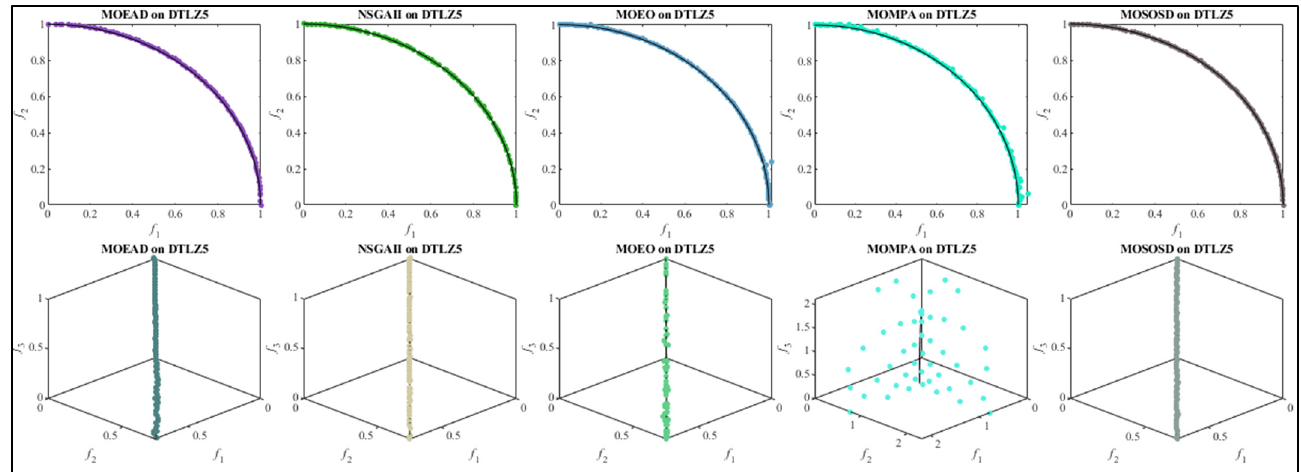
Figure 6. The Pareto front for DTLZ5 using various algorithms at 𝑀 = 2, 3 .